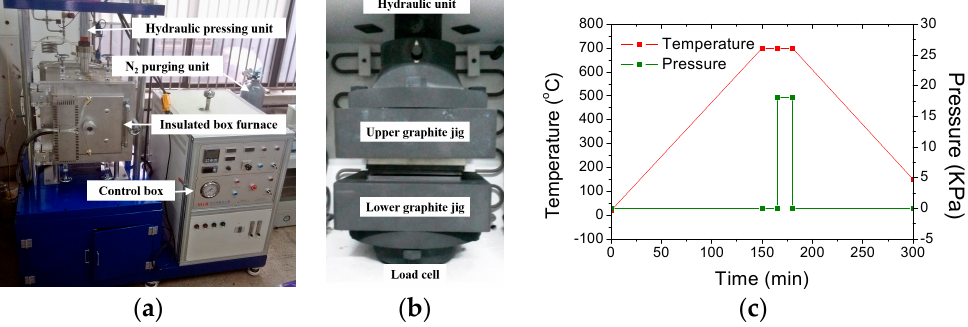
Figure 3. Photographs of the ( a ) constructed glass molding system; ( b ) graphite pressing jig in the box furnace; and ( c ) temperature and pressure history during the glass molding process.